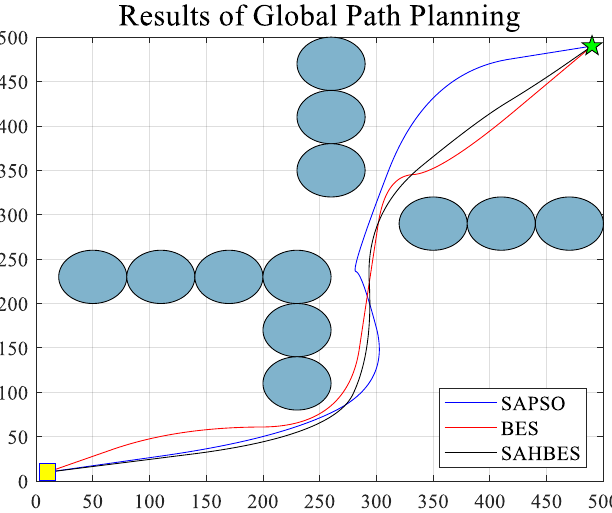
Figure 9. Global path planning chart of trap obstacles simulation I.